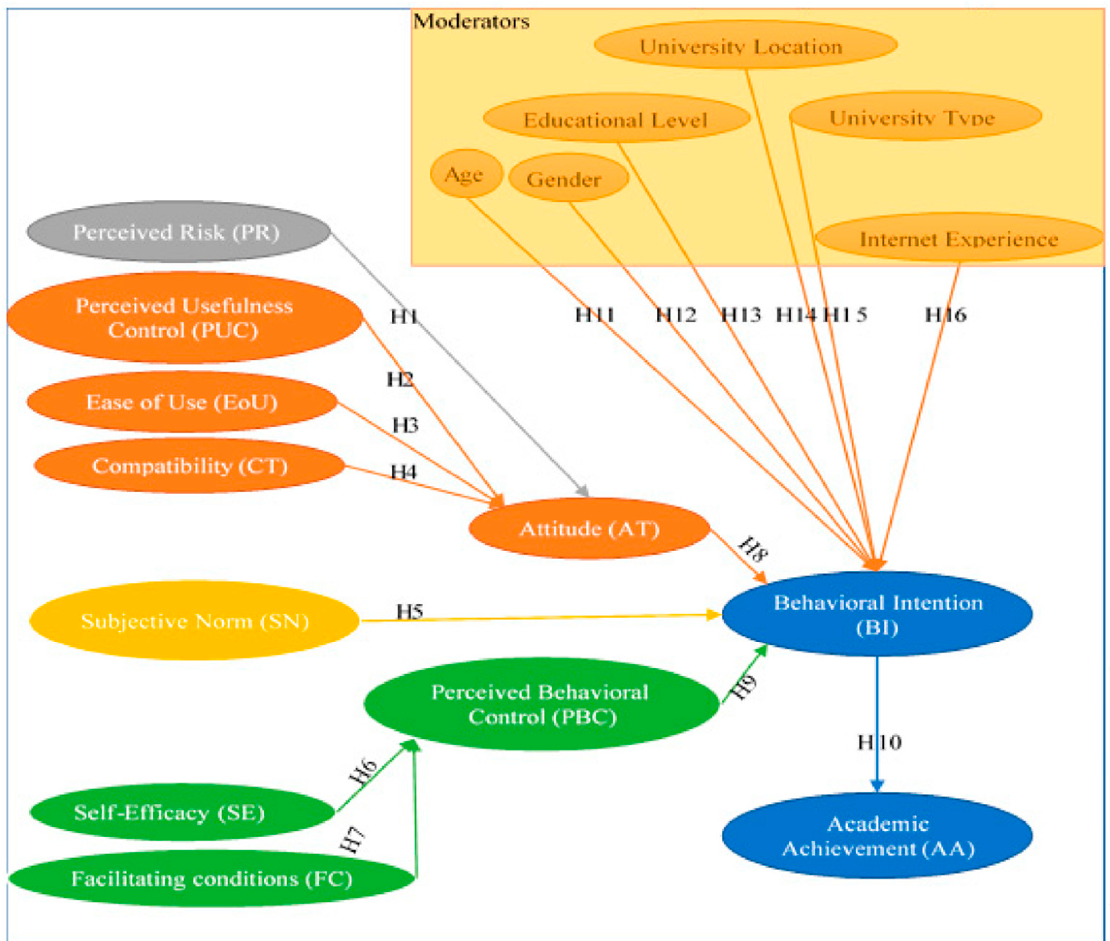
Figure 1. The suggested model adopted from [1] based on DTPB [26].